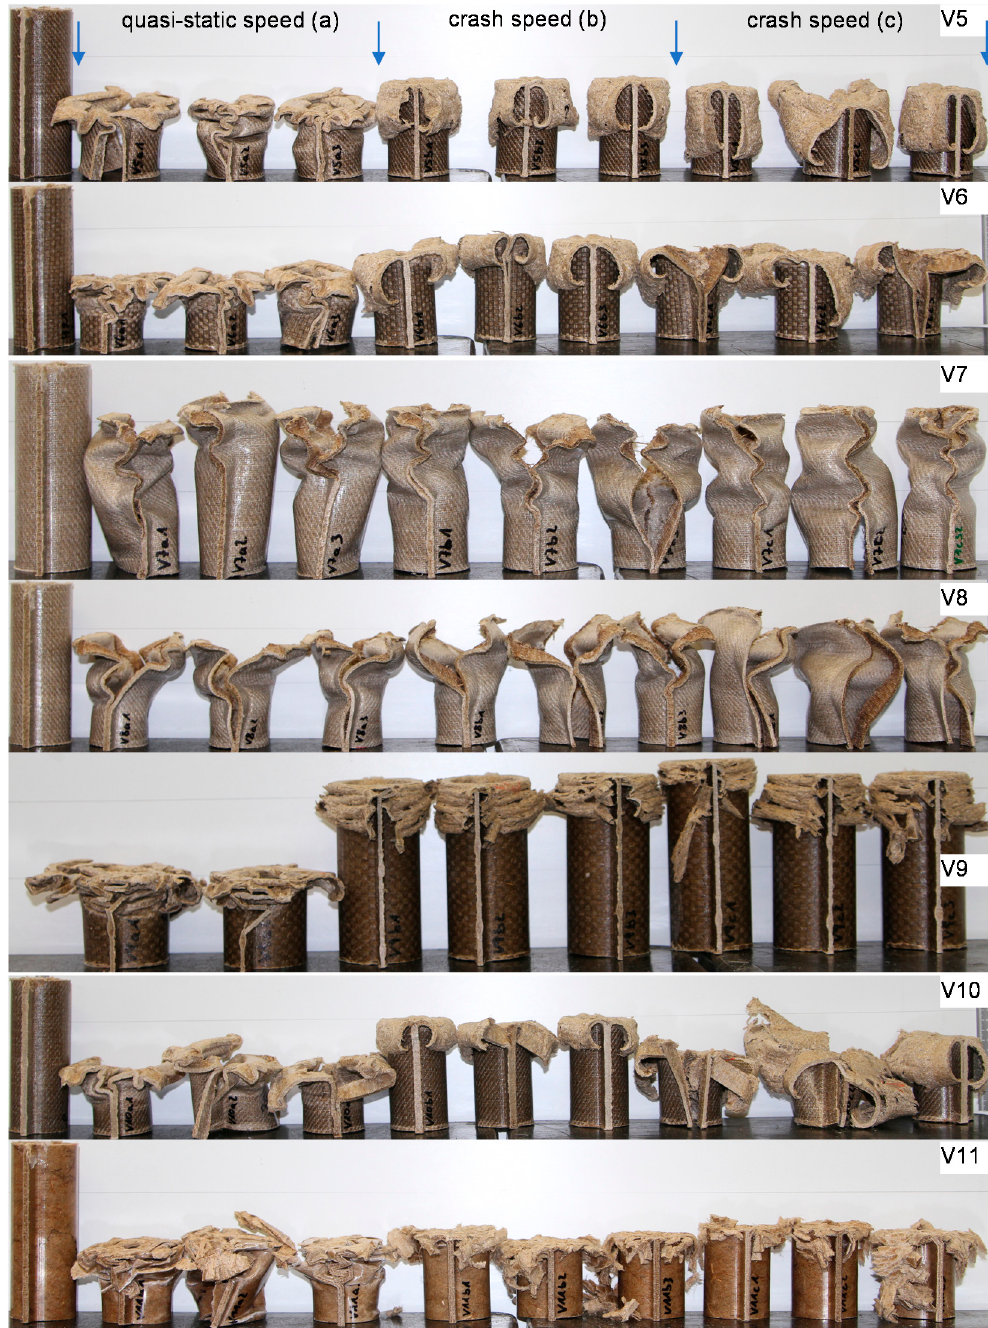
Figure 4. Deformed specimens of test series V5–V11. Left: undeformed specimen; middle: specimens tested at quasi-static speed; right: specimens tested at crash speed.